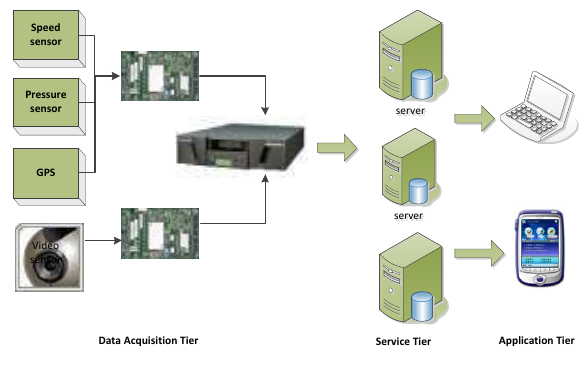
Figure 1. The platform